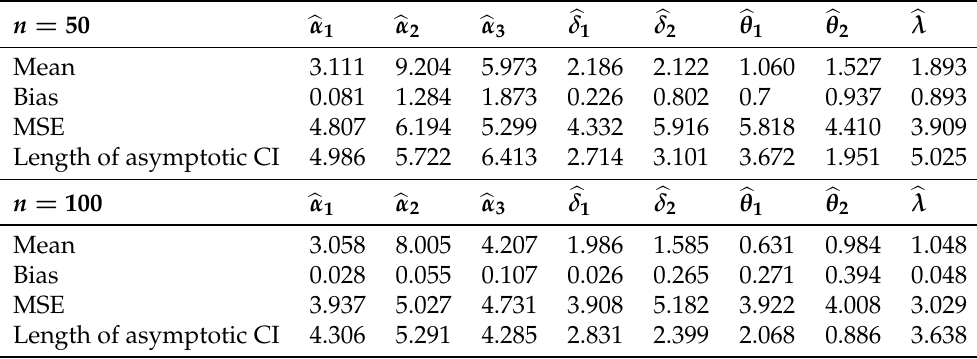
Table 1. Simulation results for sample size n = 50 and ψ = ( α 1 , α 2 , α 3 , δ 1 , δ 2 , θ 1 , θ 2 , λ )